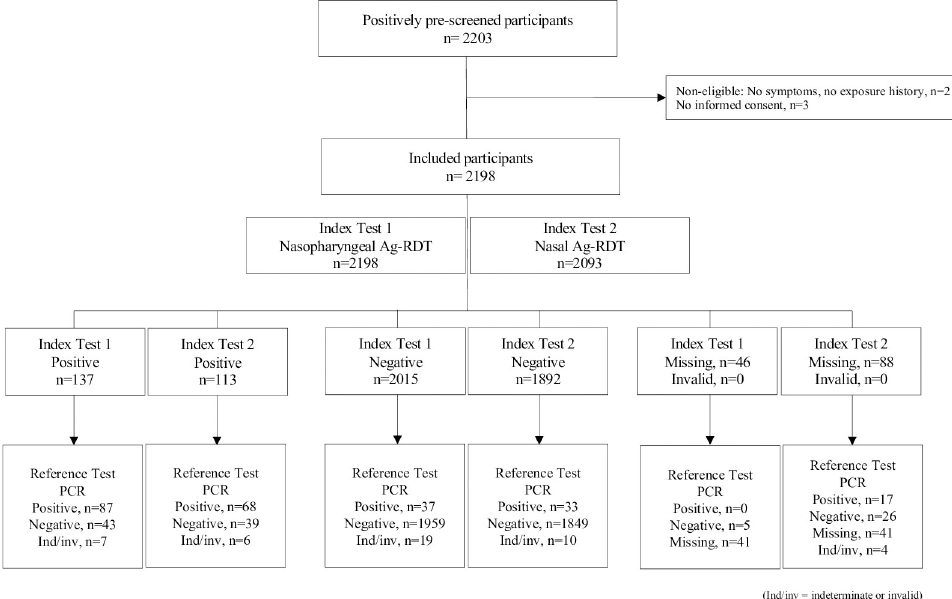
Fig 1. STARD diagram of participant